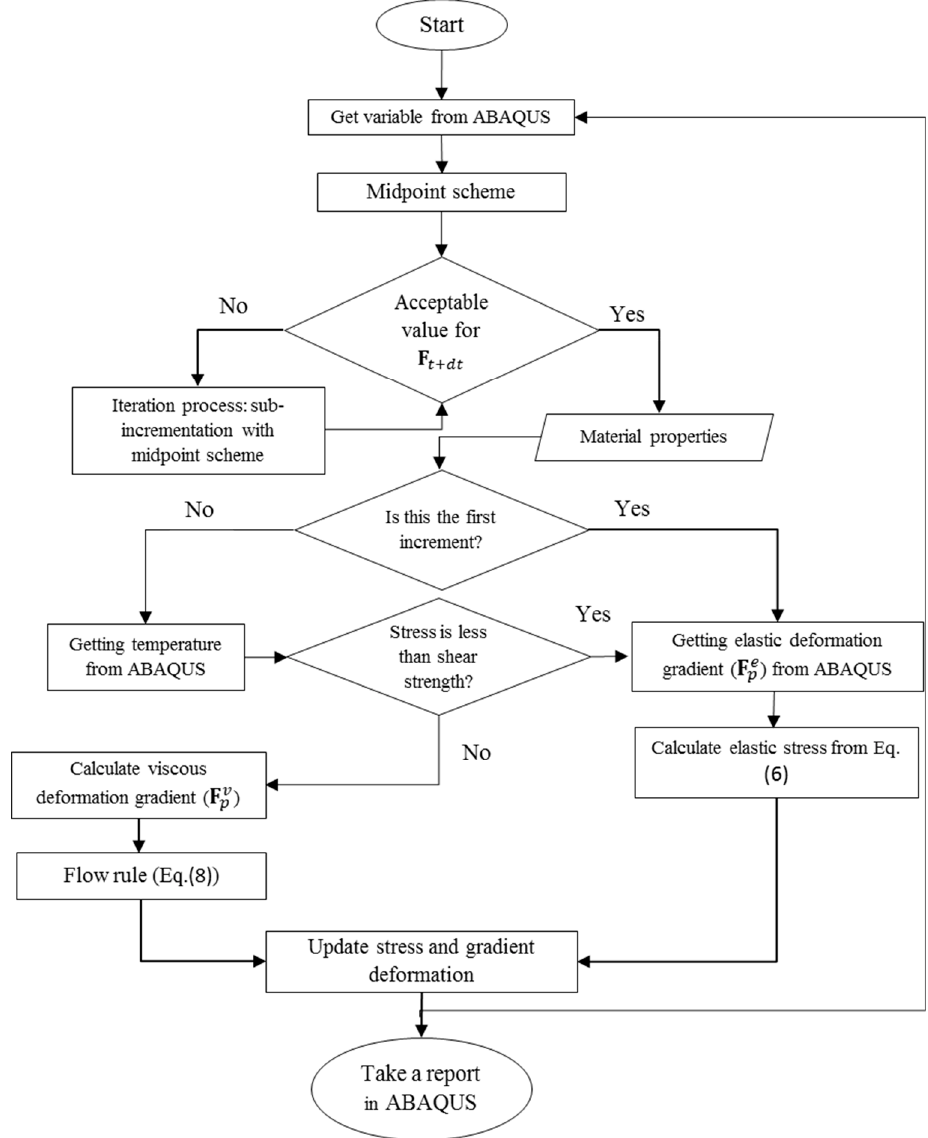
Figure 5. Block diagram of processing in ABAQUS.